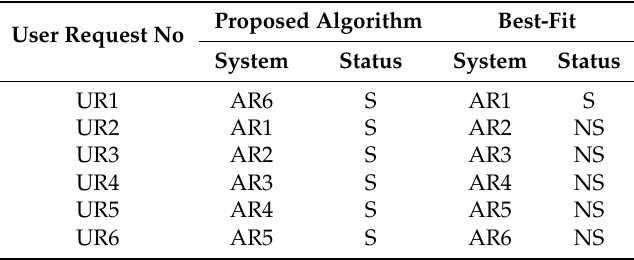
Table 4. Selected machined after applying the proposed algorithm and best-fit